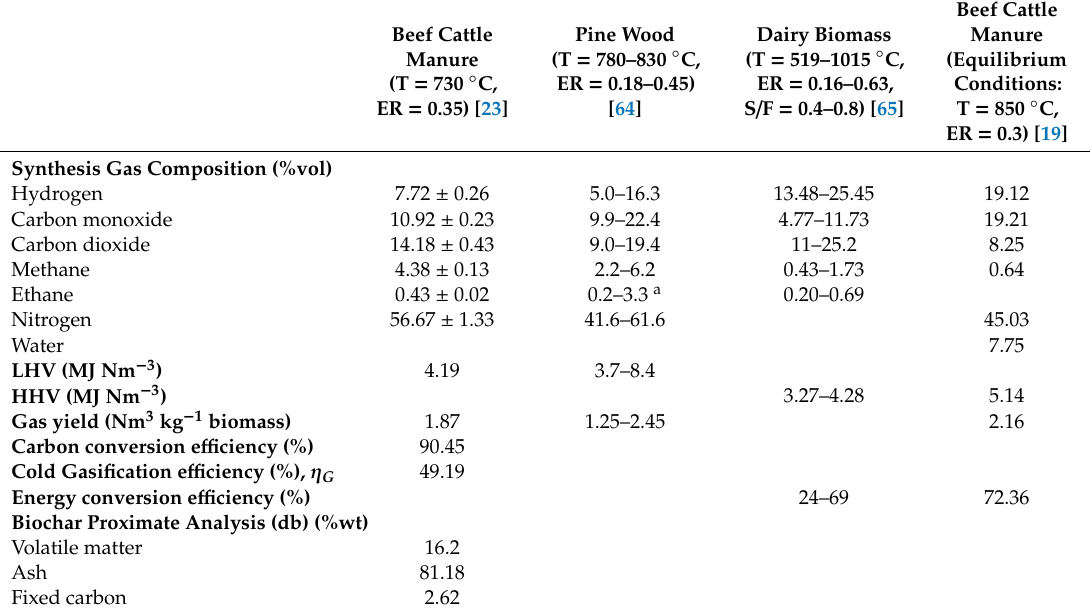
Table 7. Synthesis gas